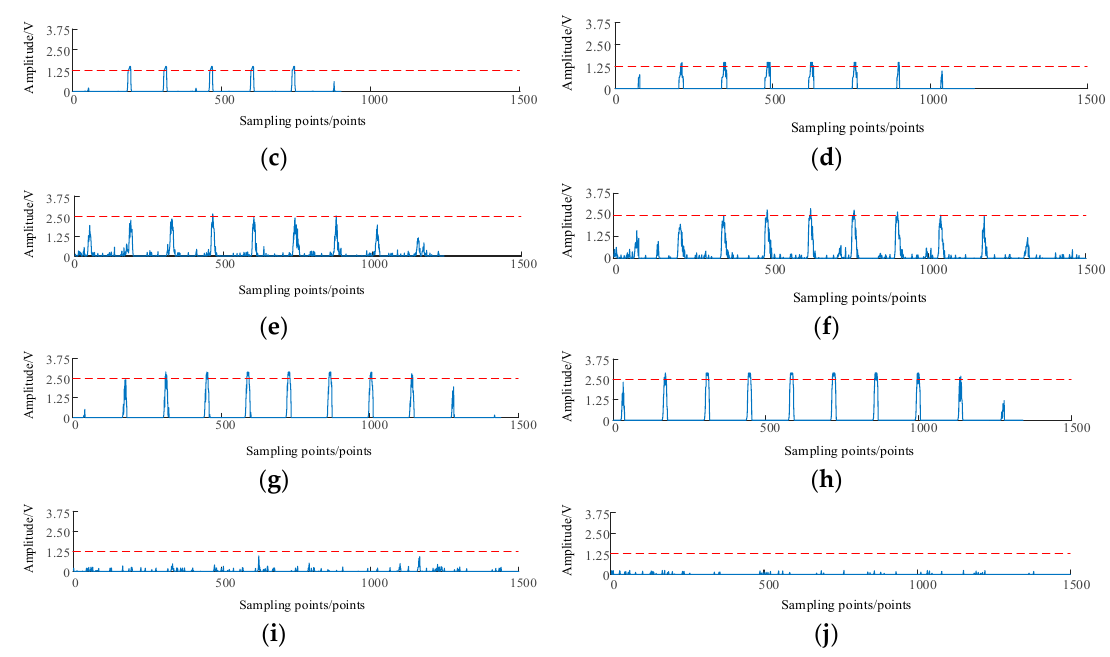
Figure 7. Signal with and without flaw (( a ) Depth of inner transverse flaw was 0.045 mm; ( b ) Depth of inner longitudinal flaw was 0.045 mm; ( c ) Depth of outer transverse flaw was 0.045 mm; ( d ) Depth of outer longitudinal flaw was 0.045 mm; ( e ) Depth of inner longitudinal flaw was 0.073 mm; ( f ) Depth of outer longitudinal flaw was 0.073 mm; ( g ) Depth of inner longitudinal flaw was 0.10 mm; ( h ) Depth of outer longitudinal flaw was 0.10 mm; ( i ) Signal without flaw and with strong noise; ( j ) Signal without flaw and with weak noise).